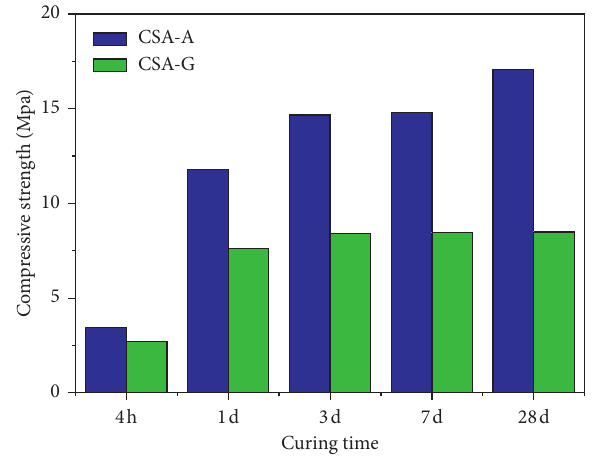
Figure 9: Compressive strength test results.